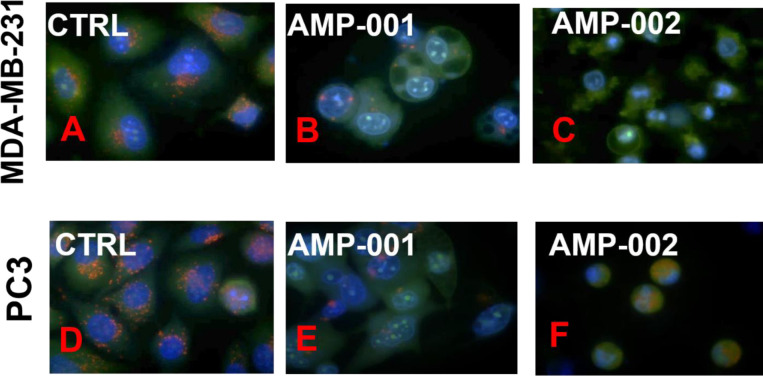
Lysosomal instability evidenced by release of acridine orange in AMP-001/002 treated (30 mM) TNBC MDA-MB-231 and in PC3 cells.TNBC MDA-MB-231 cells (A, B, C) and PC3 prostate cells (D, E, F) were treated with AMP-001/002 respectively and uptake of acridine orange dye was assessed by confocal microscopy, N = 4, p <0.006.